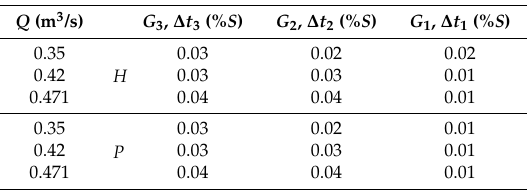
Table 4. Iteration uncertainties in the simulations.